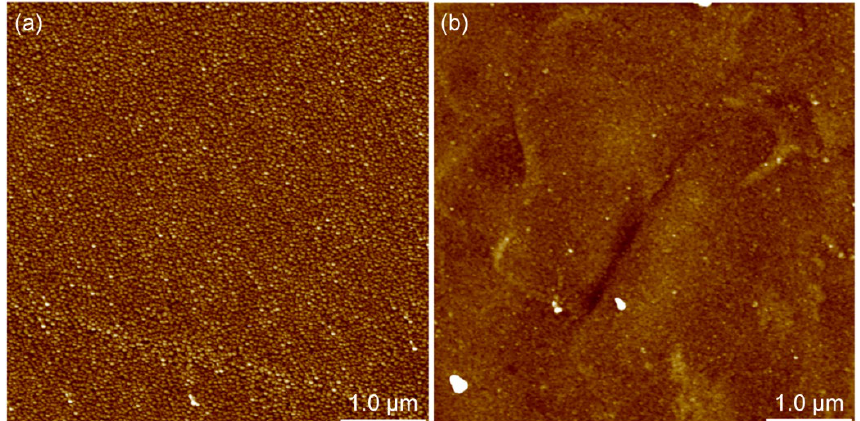
Figure 7. AFM image of 5 μm × 5 μm surface of PAH/PAA multilayer made of 2 bilayers on ( a ) Si substrate and ( b ) Ti substrate. The higher areas are shown in a lighter color; z-scale value is 20 nm.